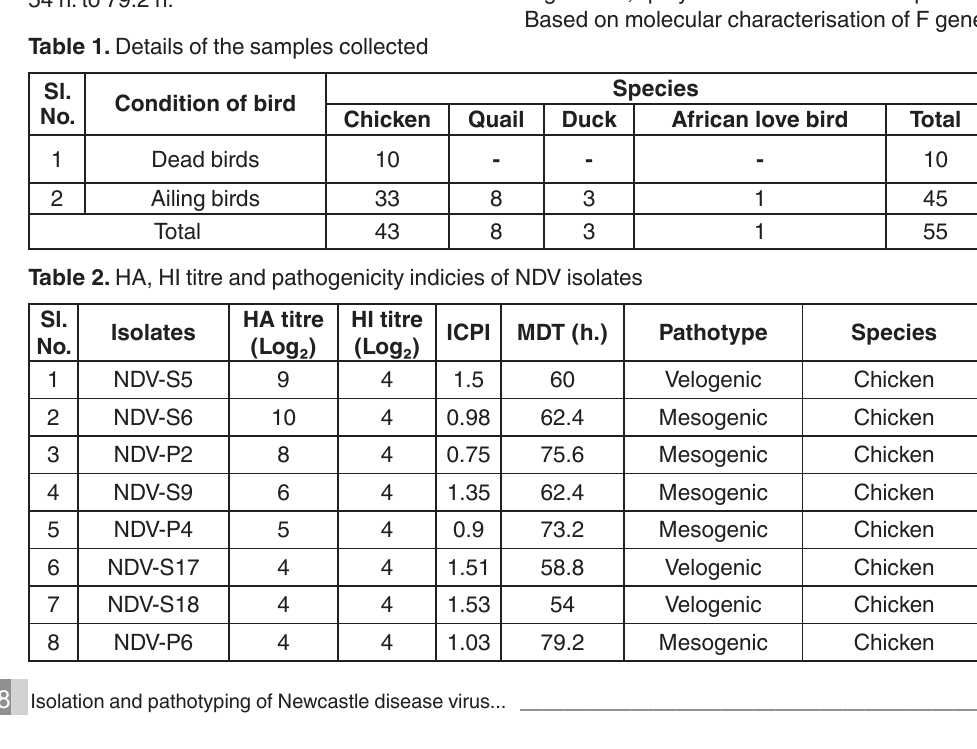
Based on molecular characterisation of F gene